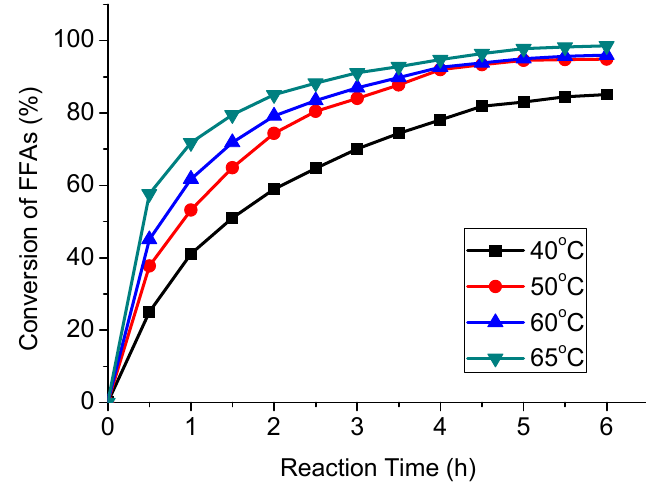
Figure 3. Effect of reaction temperature on the esterification.